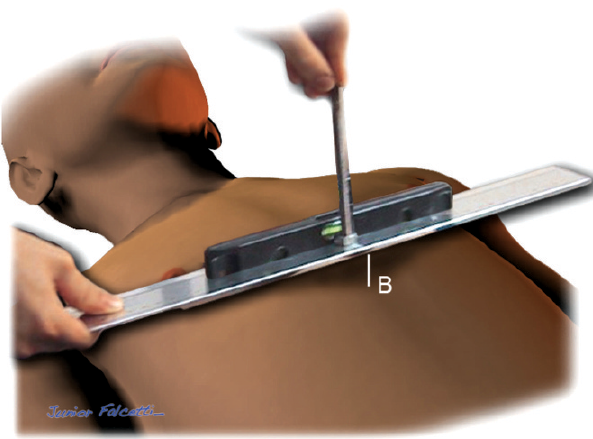
Figure 2 - Measurement B) The lowest depth of the defect, using the highest point of the anterior chest wall and the